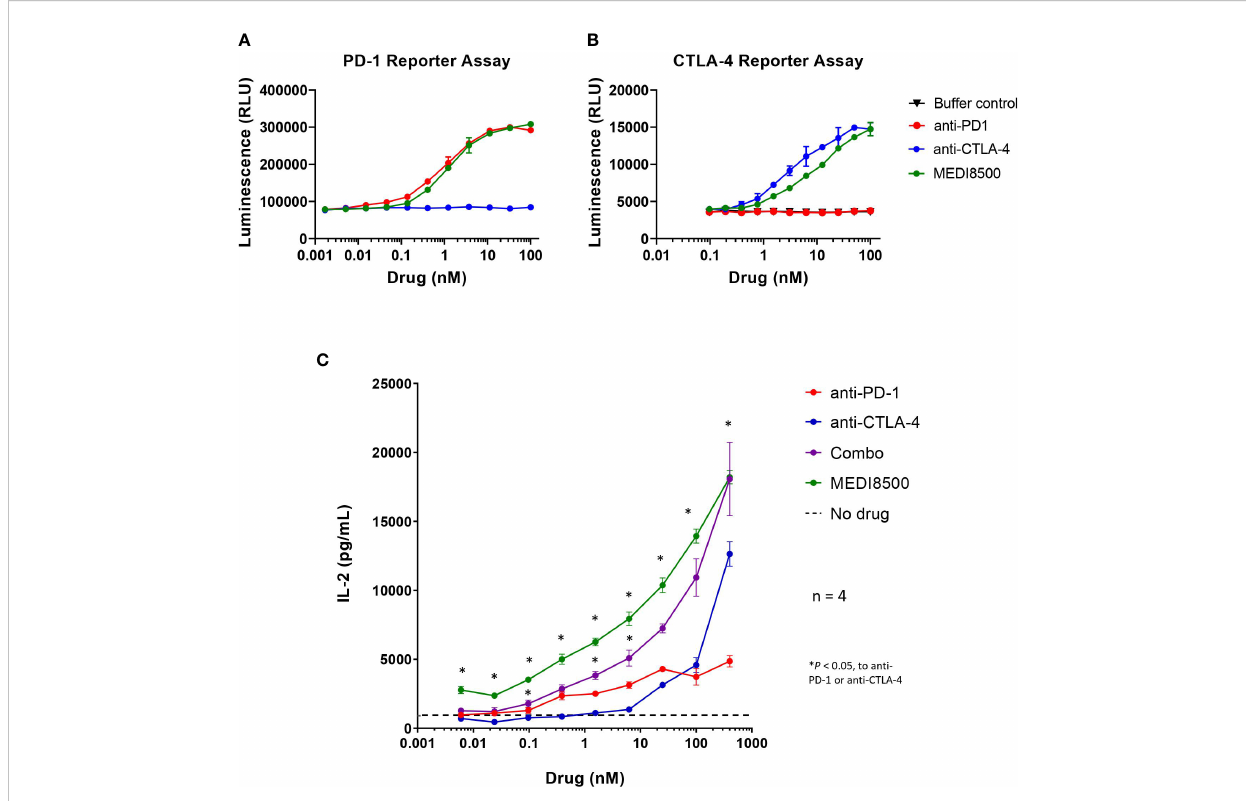
FIGURE 1 Increased in vitro potency with antibody combination and MEDI8500 compared to monotherapies (A) Bioluminescence levels in a PD-1/PD-L1 blockade bioassay after 5 hours and 40 minutes of incubation with increasing doses (3-fold) of either anti-PD-1, anti-CTLA-4 or MEDI8500. (B) Bioluminescence levels in a CTLA-4 blockade bioassay after 6 hours of incubation with increasing doses (3-fold) of either anti-PD-1, anti-CTLA-4 or MEDI8500. Data are represented as Mean ± SD of duplicates in each point. (C) Levels of IL-2 secretion by human PBMCs after 72h of in vitro treatment with increasing doses (4-fold) of either anti-PD-1, anti-CTLA-4, combination of anti-PD-1 + anti-CTLA-4 or MEDI8500, on an anti-huCD3 + SEB stimulation assay. Data are represented as Mean ± SEM for 4 independent donors. A two-way ANOVA followed by Tukey ’ s multiple comparison was used to evaluate statistical differences between antibody combination or MEDI8500 and single agents at each concentration; statistically signi fi cant differences are noted when * P <